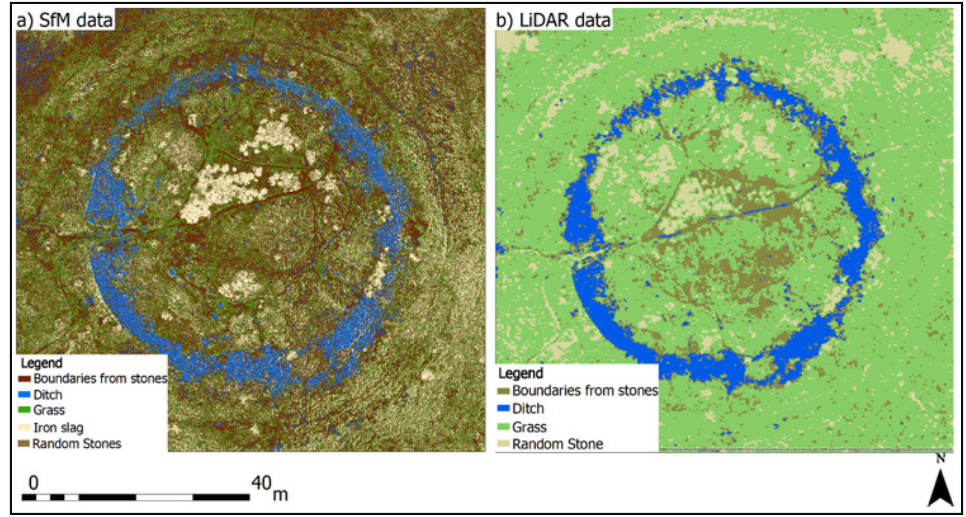
Figure A2. Depicts the results obtained from ISO Cluster classification: This is a comprehensive interpretation map highlighting the main detected features from SfM photogrammetry ( a ) and Lidar ( b ) at the study area. Table A2. A summary of the archaeological features detected in this study after implementing visualization methods, ISODATA clustering algorithm, and SVM classification using LiDAR and SfM datasets.